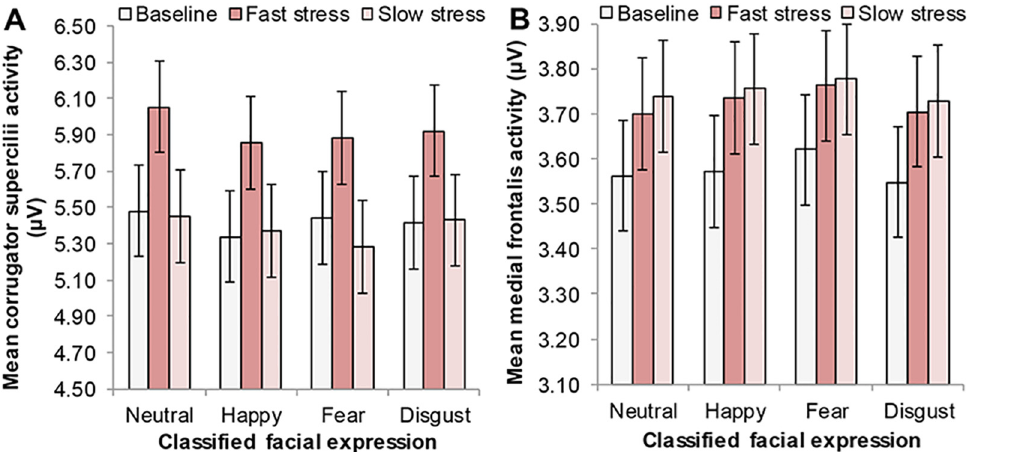
Fig 5. Mean facial muscle activity of receivers per odor condition during classification of presented (emotional) facial expressions. Odor condition: Baseline, fast stress, slow stress. Facial expressions that had to be classified: Neutral, happy, fear, disgust. For clarification purposes, the display of mean facial muscle activity on the emotional facial expression classification task was collapsed over the variable noise level (20%, 40%, 60%, 80%, 100%). (A) Mean corrugator supercilii activity, averaged over 1 second following the onset of the presented expression. (B) Mean medial frontalis activity, averaged over 1 second following the onset of the presented expression. Error bars reflect 68% within-subjects CI of the main effect of odor.